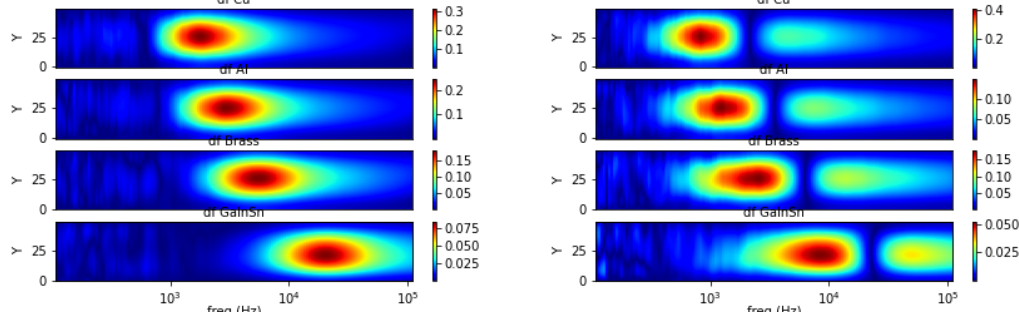
Figure 18. Z ( left ) and θ ( right ) spectral gradient (df) metallic samples with conductivity variations.